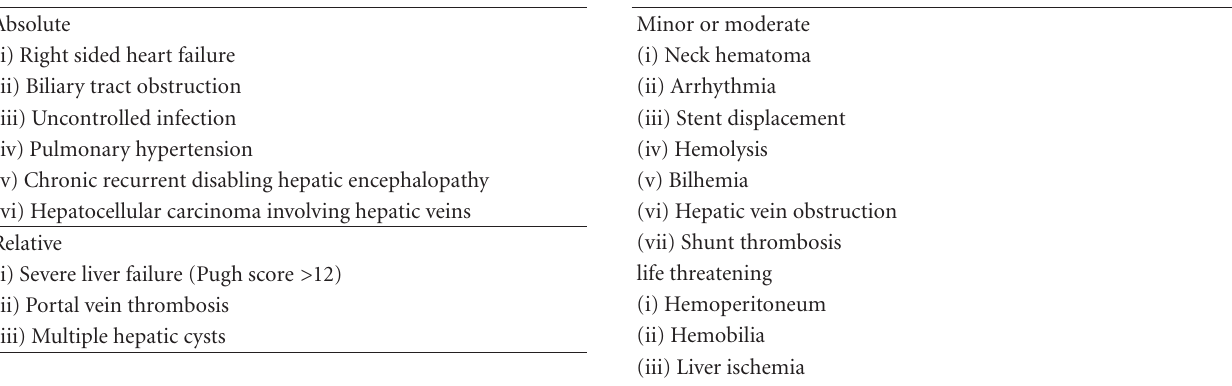
Table 2: Acute complications after TIPS placement.